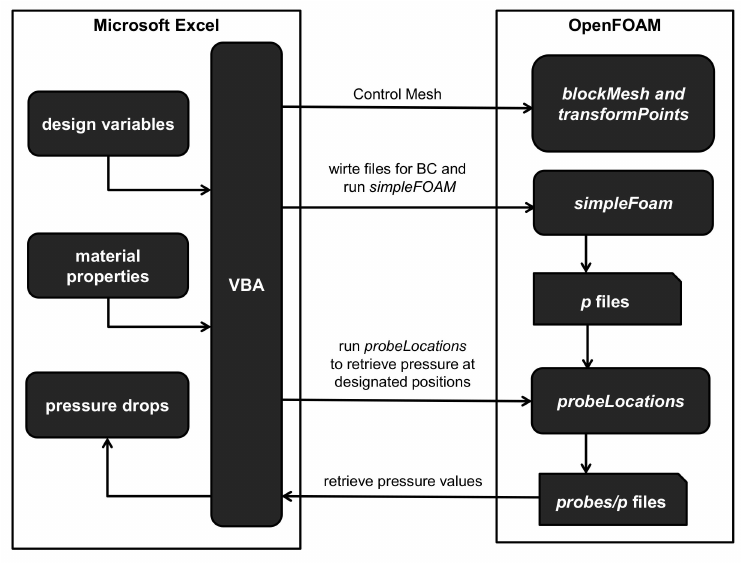
Figure 5. Schematic diagram for